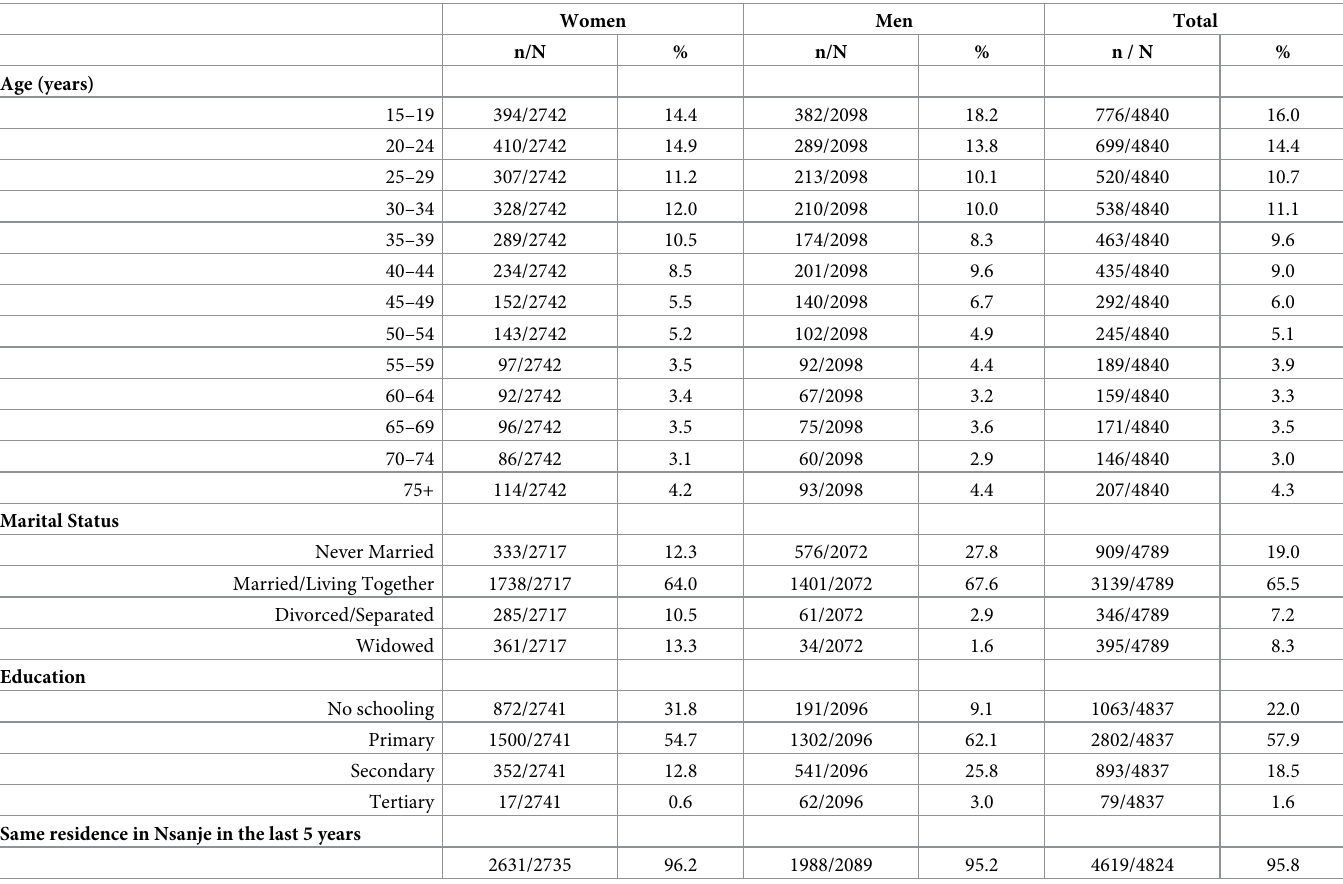
Table 1. Sociodemographic characteristics of